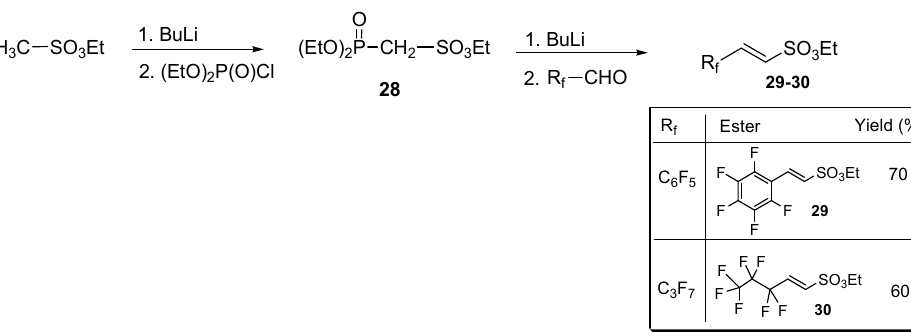
Figure 2. The Wittig–Horner route for synthesizing both aliphatic and aromatic perfluorinated α , β -unsaturated sulfonic esters 29 and 30 (yields in the table are referred to the second step).